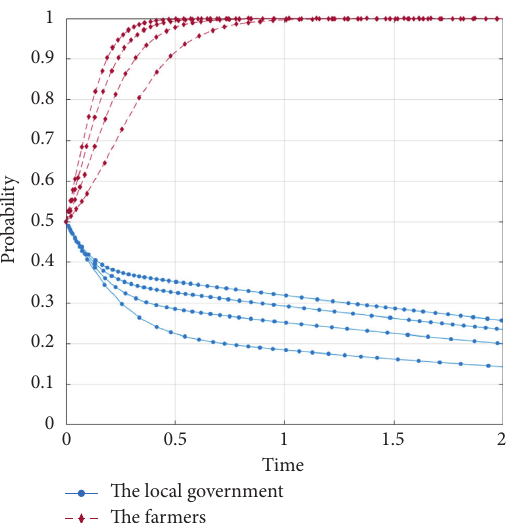
Figure 4: Evolution trajectory of the game behavior between the local government and farmers under different rights-safeguarding cost.